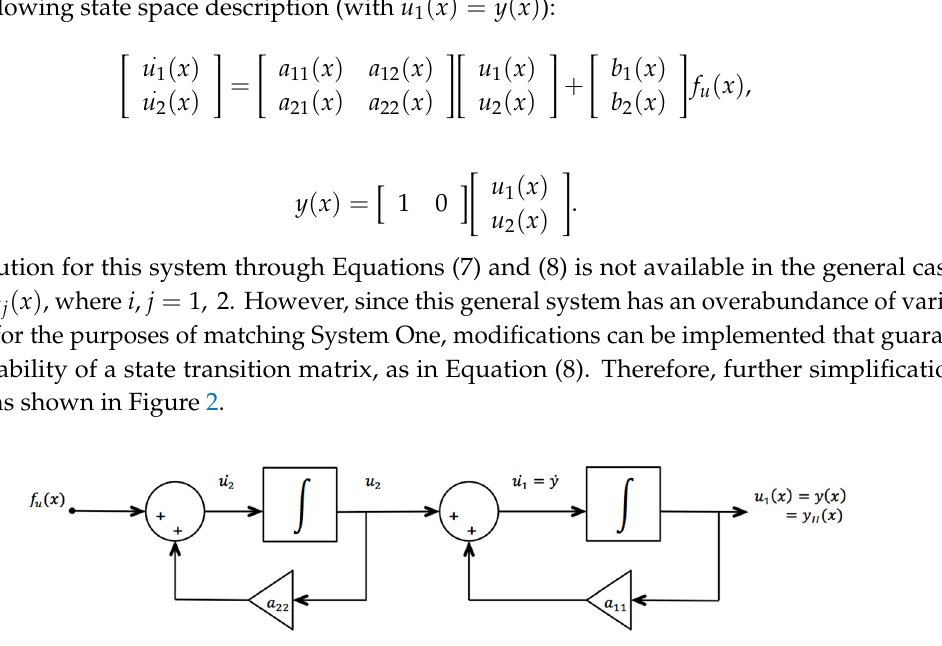
Figure 2. System Two modifications from the most general system include a 21 ( x ) = 0, a 12 ( x ) = 1, and b 1 = 0, b 2 = 1. y II ( x ) indicates a System Two output.